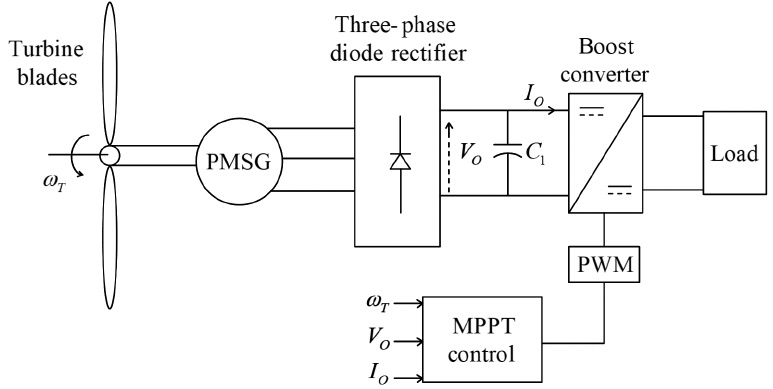
Figure 1. Simplified scheme of a direct–drive PMSG–based WT